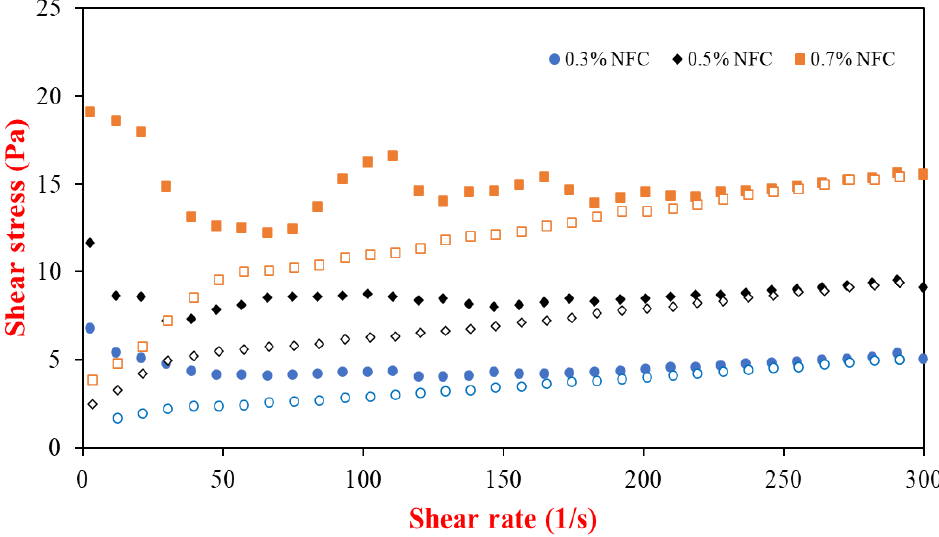
Figure 1. Flow curves of emulsion stabilized by NFC at various concentrations, in which closed symbols represent the upward curves and open symbols represent downward curves.